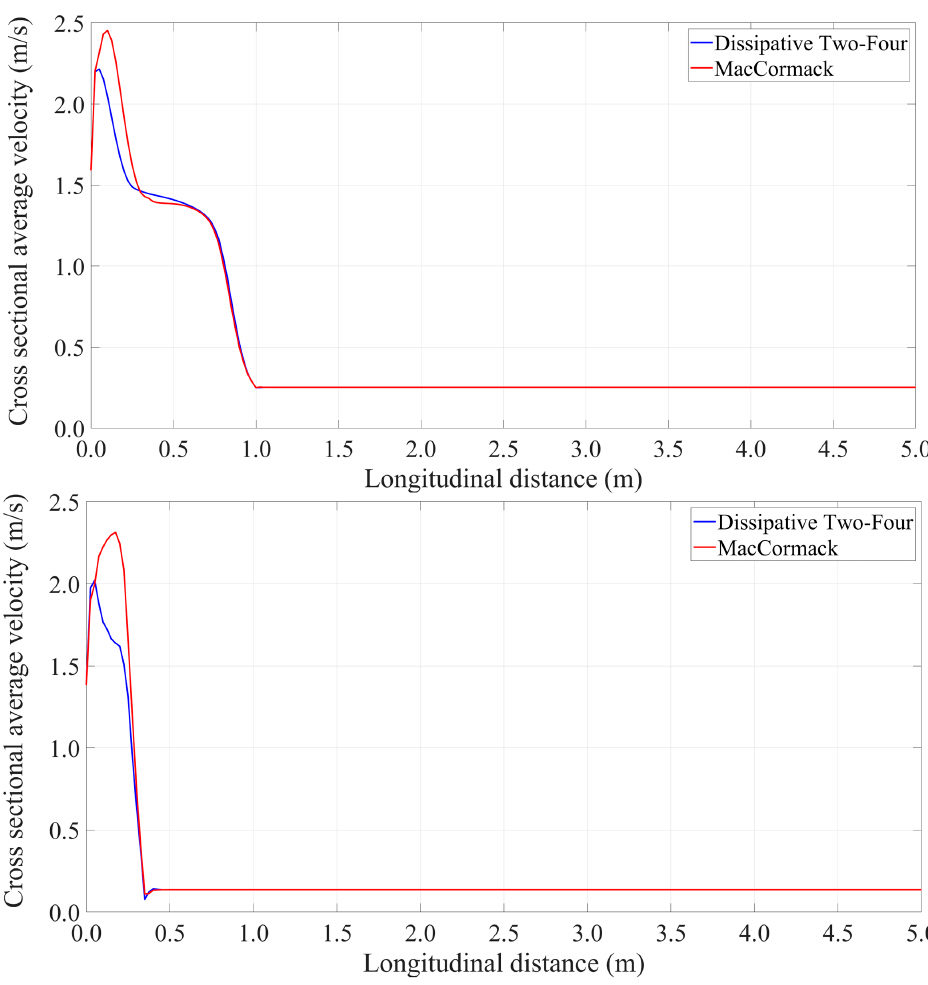
Figure 15. Numerical results for the mean stream-wise velocity along the channel length: Test case 1 ( top ), and test case 3 ( bottom ).